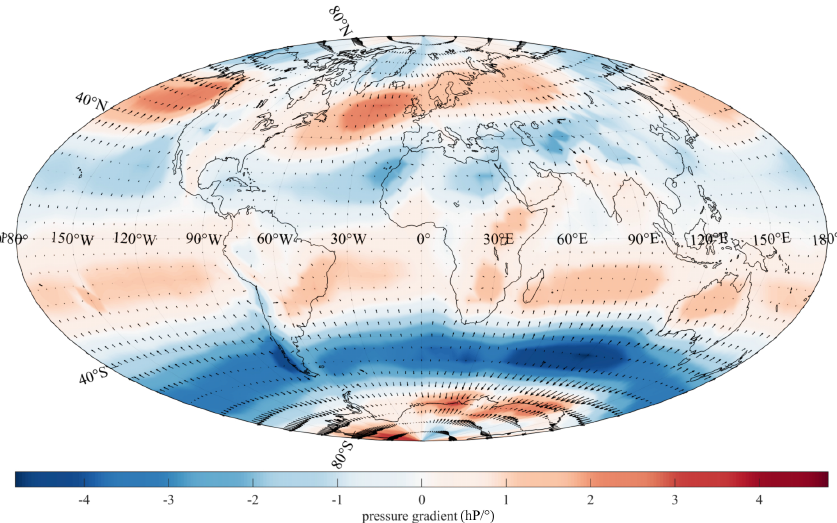
Figure 2. Time average of the spatial pressure gradients from 1850 to 2020 (i.e., winds up to a constant) at sea level (Hammer–Aitoff